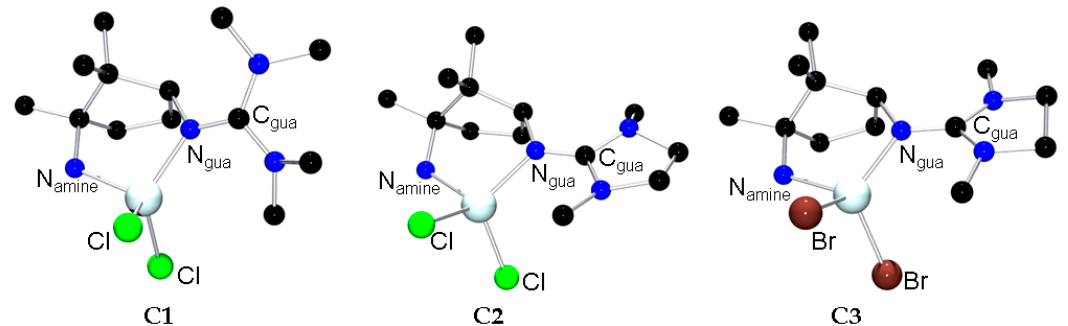
Figure 2. Molecular structures in the solid state of C1 – C3 . H atoms are omitted for clarity.